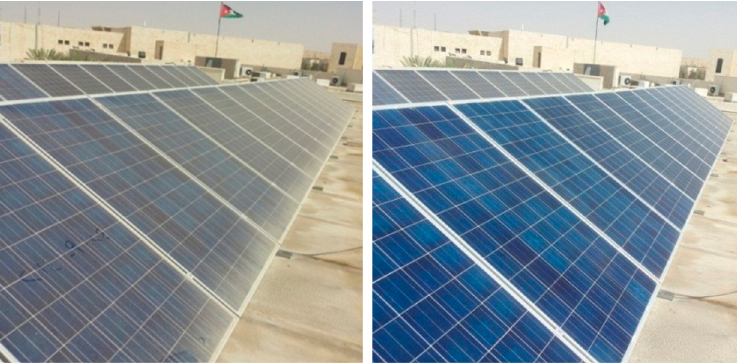
Figure 1. A 7.98 kWp photovoltaic (PV) system installed at the Hashemite University, Zarqa, Jordan before and after cleaning (all 28 modules in the foreground were cleaned manually on 24 September 2014. Modules in the background are not part of this study).